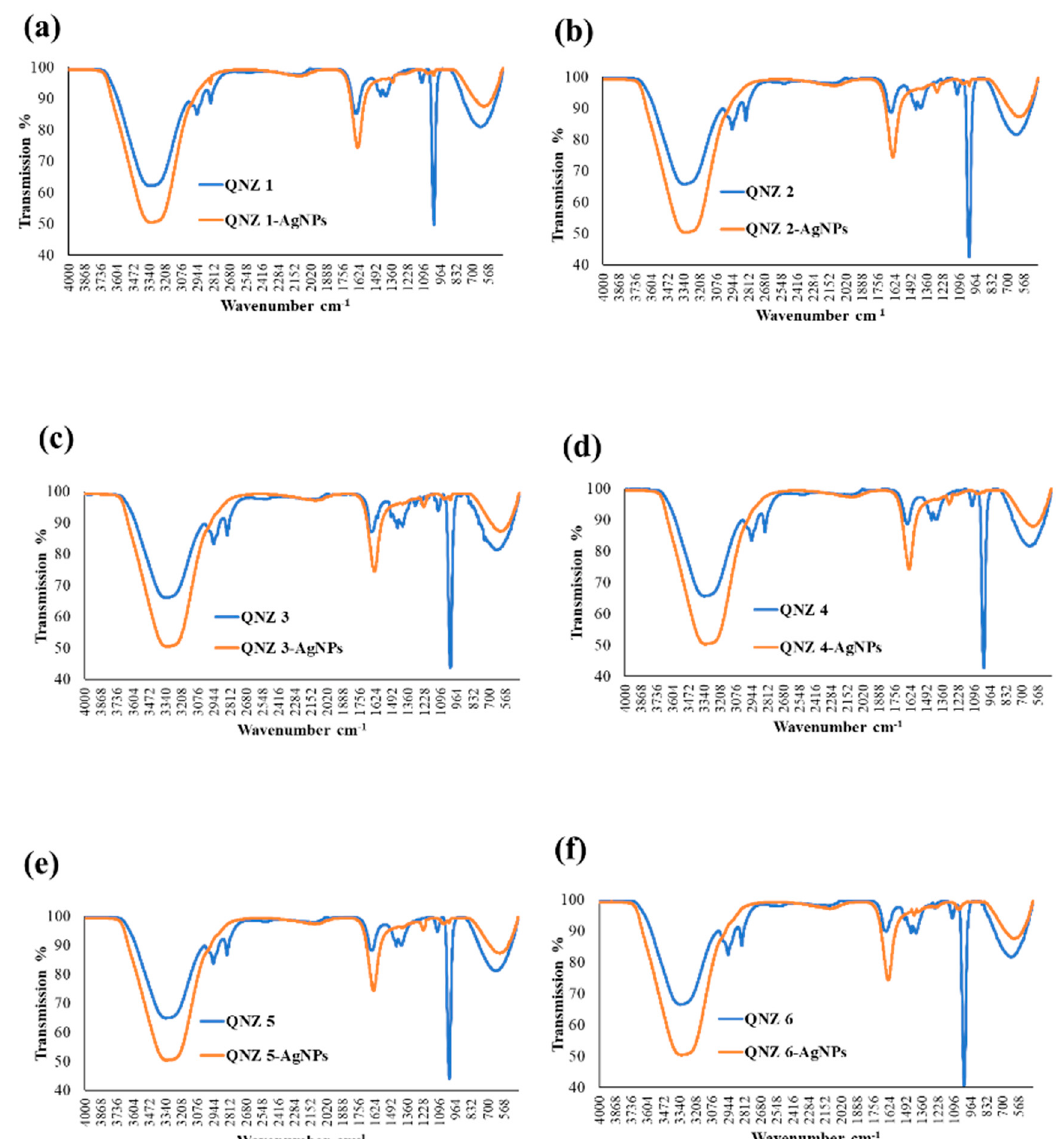
Figure 3. FT-IR spectra of each quinazolinone is compared with their nanoconjugate with AgNPs. QNZ 1, QNZ 1-AgNPs ( a ). QNZ 2, QNZ 2-AgNPs ( b ). QNZ 3, QNZ 3-AgNPs ( c ). QNZ 4, QNZ 4-AgNPs ( d ). QNZ 5, QNZ 5-AgNPs ( e ). QNZ 6, QNZ 6-AgNPs ( f ). The spectrum of each QNZ is represented in blue line and in red line after conjugations with silver. The spectra were obtained by adding 10 µL of the material into FT-IR spectrometer.